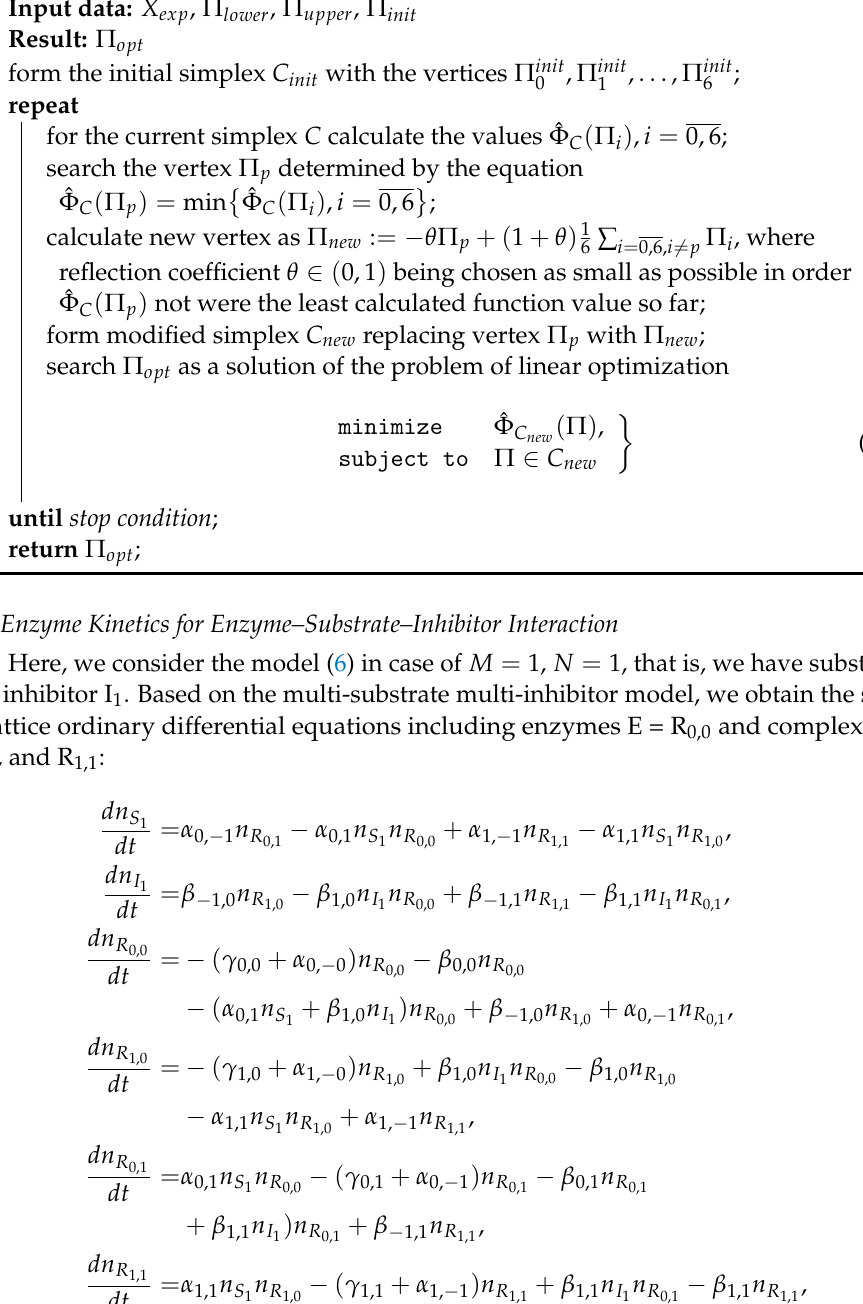
Algorithm 1: COBYLA algorithm implementation to the problem